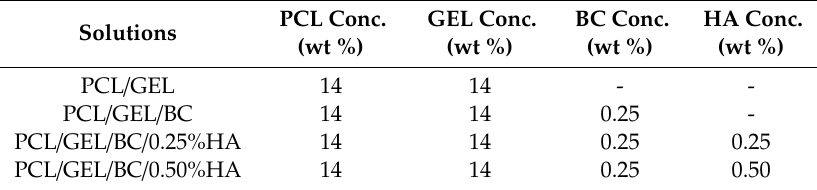
Table 1. Concentrations of polycaprolactone (PCL) / gelatin (GEL) / bacterial cellulose (BC) / hydroxyapatite (HA) solutions. Solutions